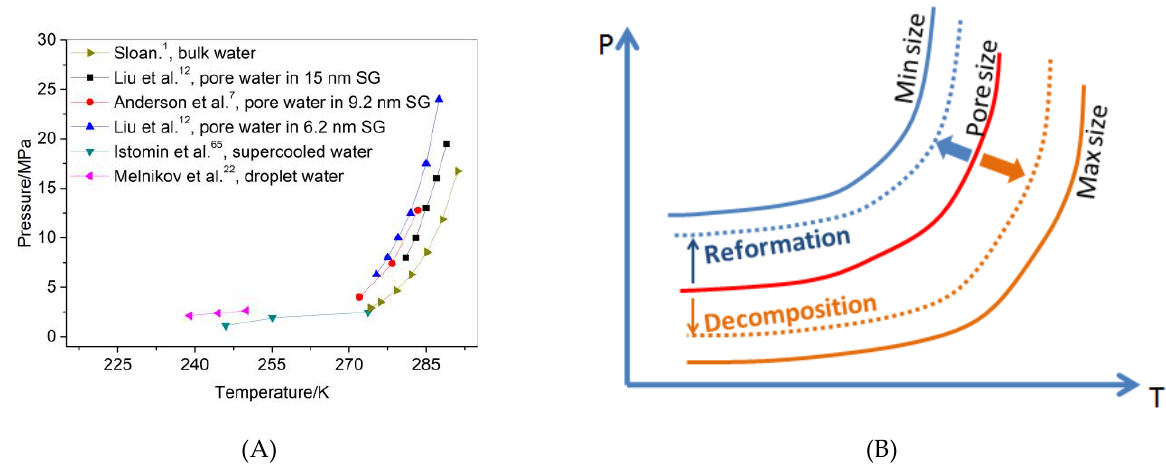
Figure 5. ( A ) Phase equilibrium of methane hydrate from pore water [7,12], bulk water1, supercooled water [65], and droplet water [22]. Pore water was confined in 6.2, 9.2, and 15 nm SG pores. ( B ) Phase equilibrium diagram of methane hydrate from pore water inside SG pores with different pore